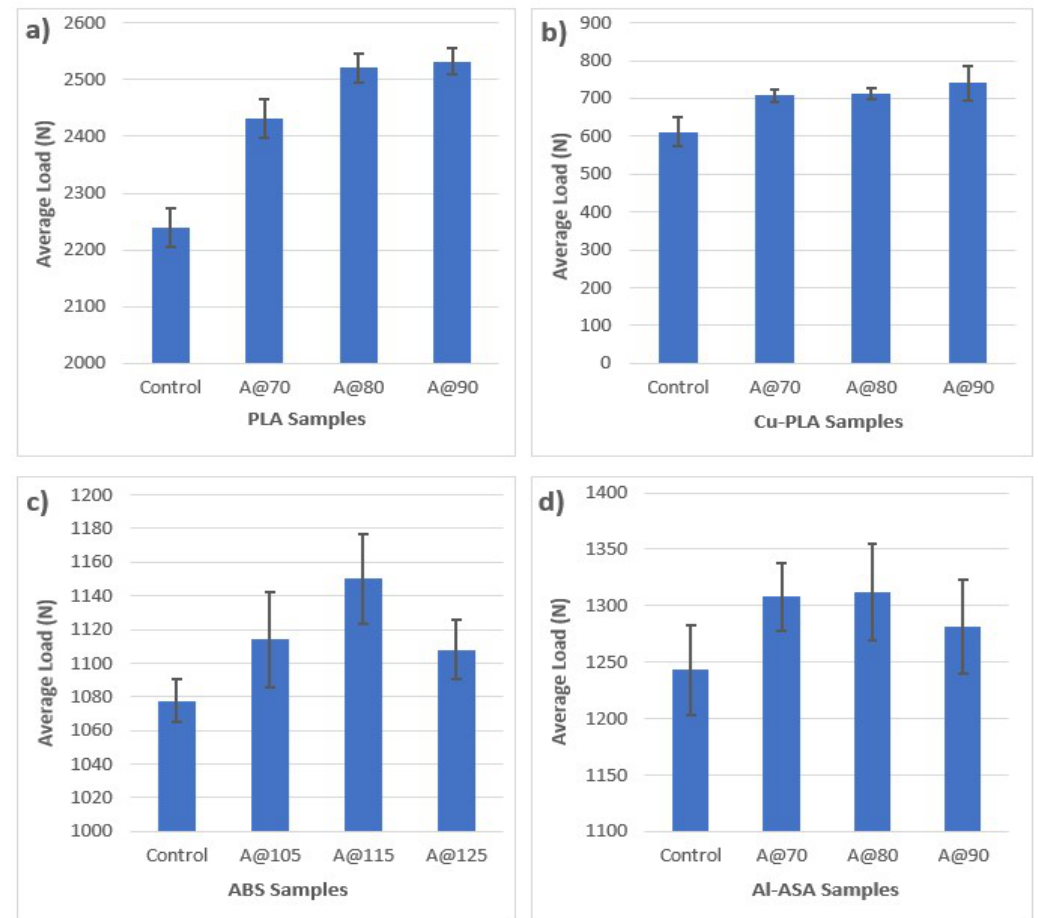
Figure 12. Results from tensile testing with standard deviation as error bars: ( a ) PLA material; ( b ) Cu-PLA material; ( c ) ABS material; ( d ) Al-ASA material.